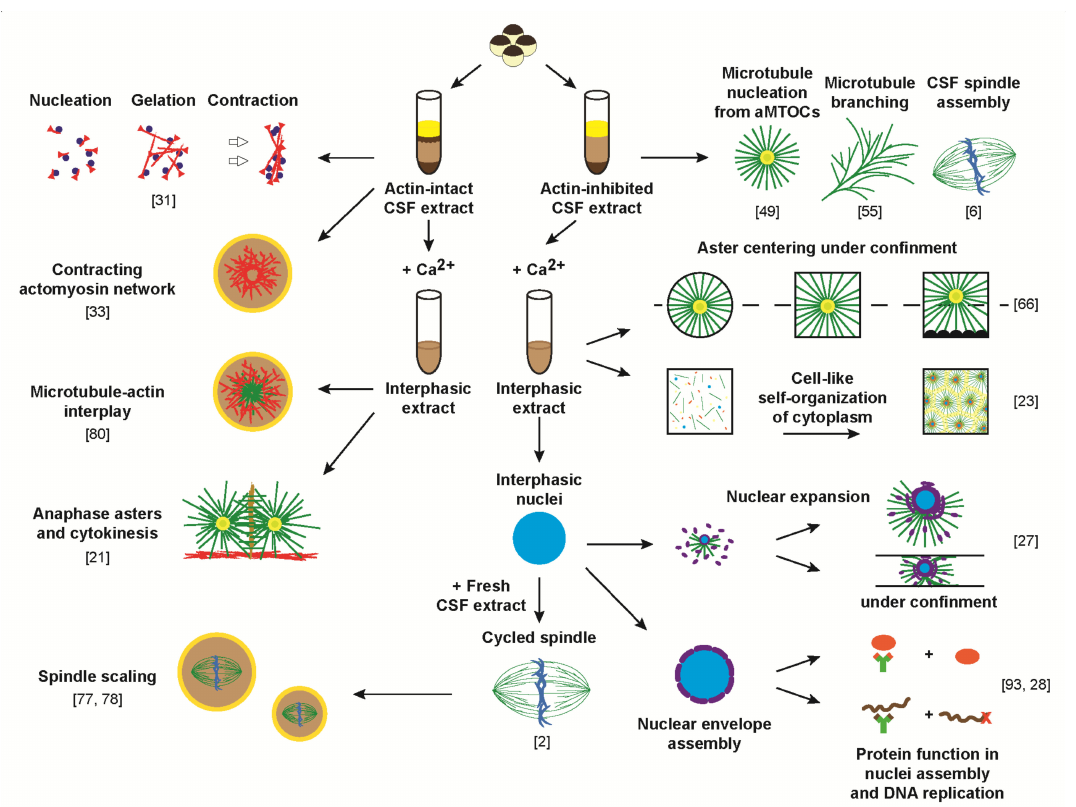
Figure 1. Reconstitution of cytoskeleton-dependent self-organization processes using the Xenopus egg extract in vitro system. Studies introducing or utilizing the reconstitution system in the context of investigating self-organization are referenced next to corresponding schematics in the order they appear in the